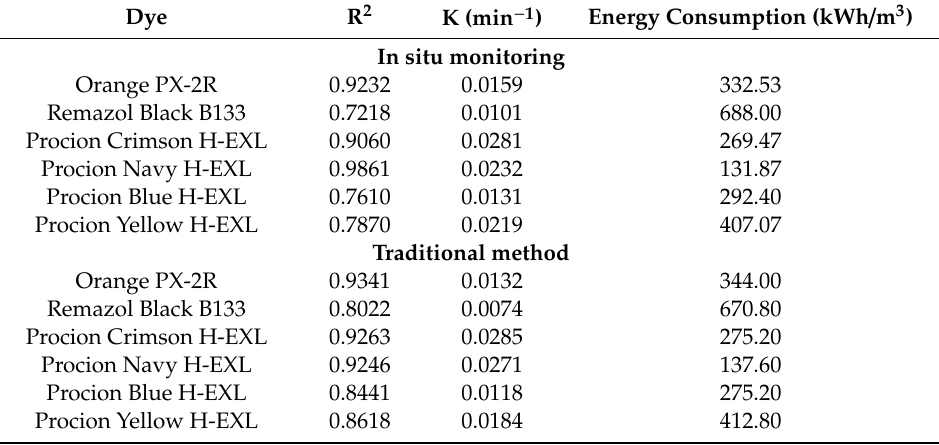
Table 1. First-order degradation rate constant, and Energy Consumption for the decolorization of azo